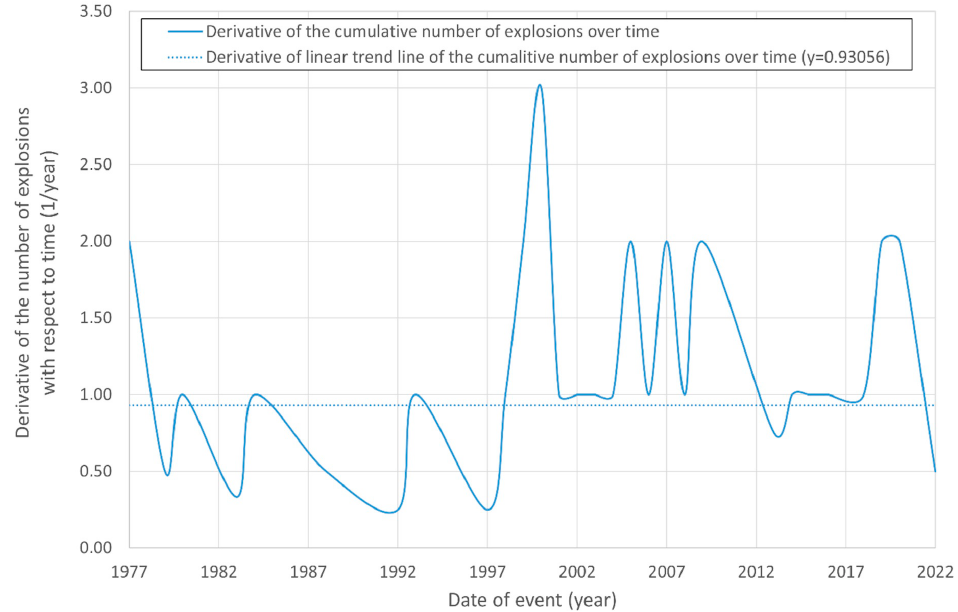
Figure 8. Instantaneous and average frequency of explosions of marine main engine turbochargers by year in the period 1977–2022.